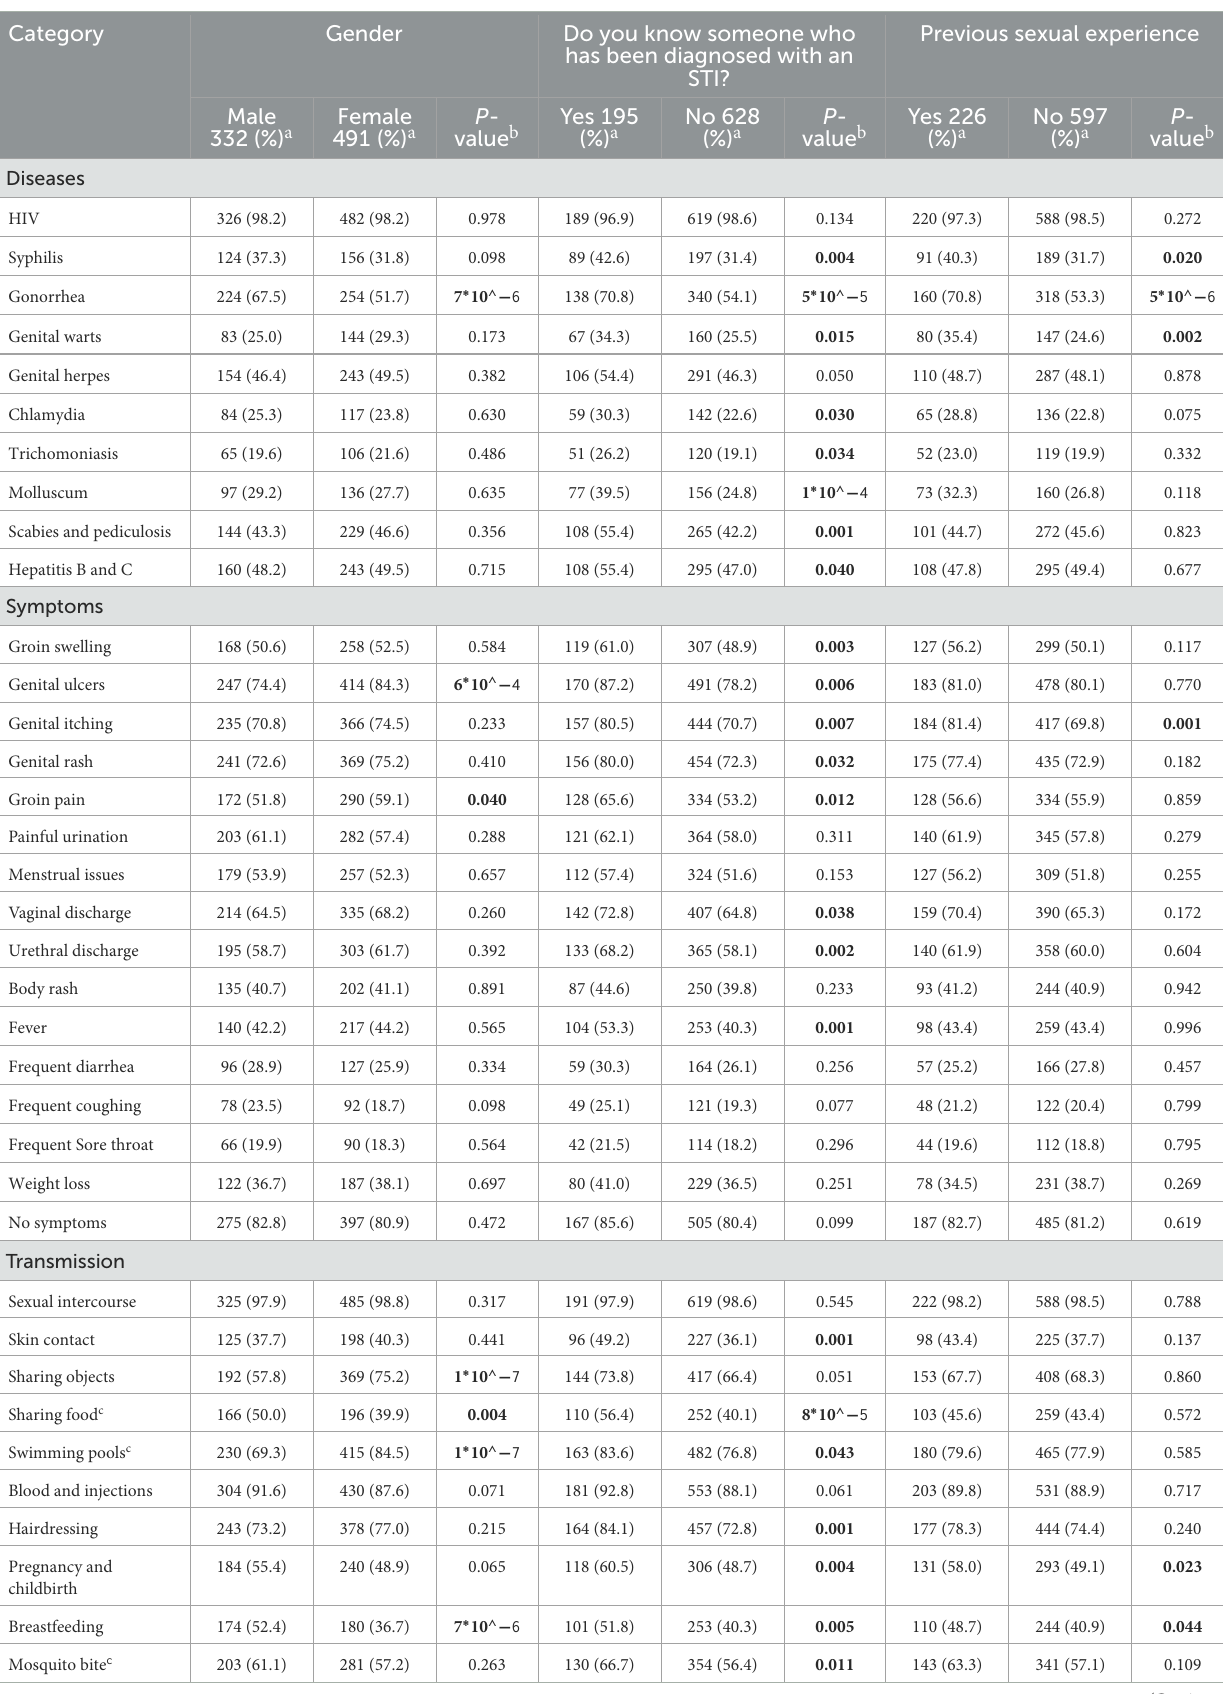
TABLE 2 Knowledge about sexually transmitted infections among non-medical undergraduates in Baghdad,